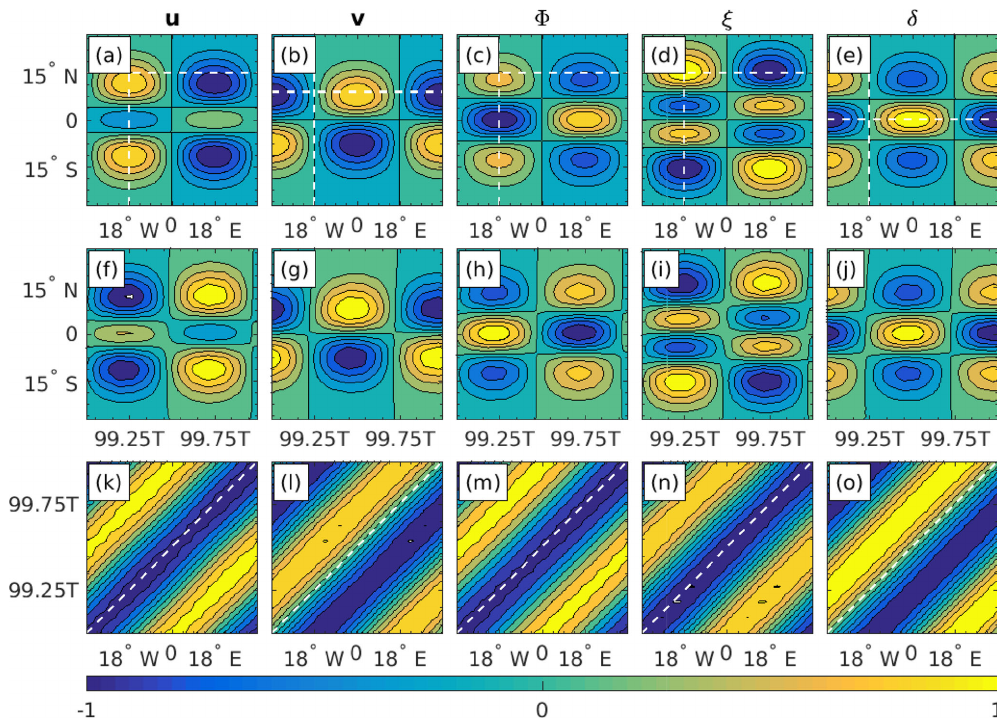
Figure 2. (a–e) The initial u,v,(cid:56) , ξ , and δ EIG wave fields, obtained using the analytic expressions from Sect. 2 and the wave parameters from Sect. 3.1. (f–j) Latitude–time Hovmöller diagrams of the simulated solutions, obtained by intersecting the fields at λ = − 18 ◦ (also indicated by the white vertical dashed lines in a–e ). (k–o) Time–longitude Hovmöller diagrams of the simulated solutions, obtained by intersecting v at φ = 9 ◦ , δ at φ = 0 ◦ and all other fields at φ = 15 ◦ (also indicated by the white horizontal dashed lines in a–e ). The simulated solutions were obtained using the equatorial channel finite-difference model. The fields are normalized on their global maximum at t = 0. The wave period for the chosen wave parameters is T = 1 . 9d. Contour levels range from − 1 . 0 to + 1 . 0 in intervals of 0 . 2.